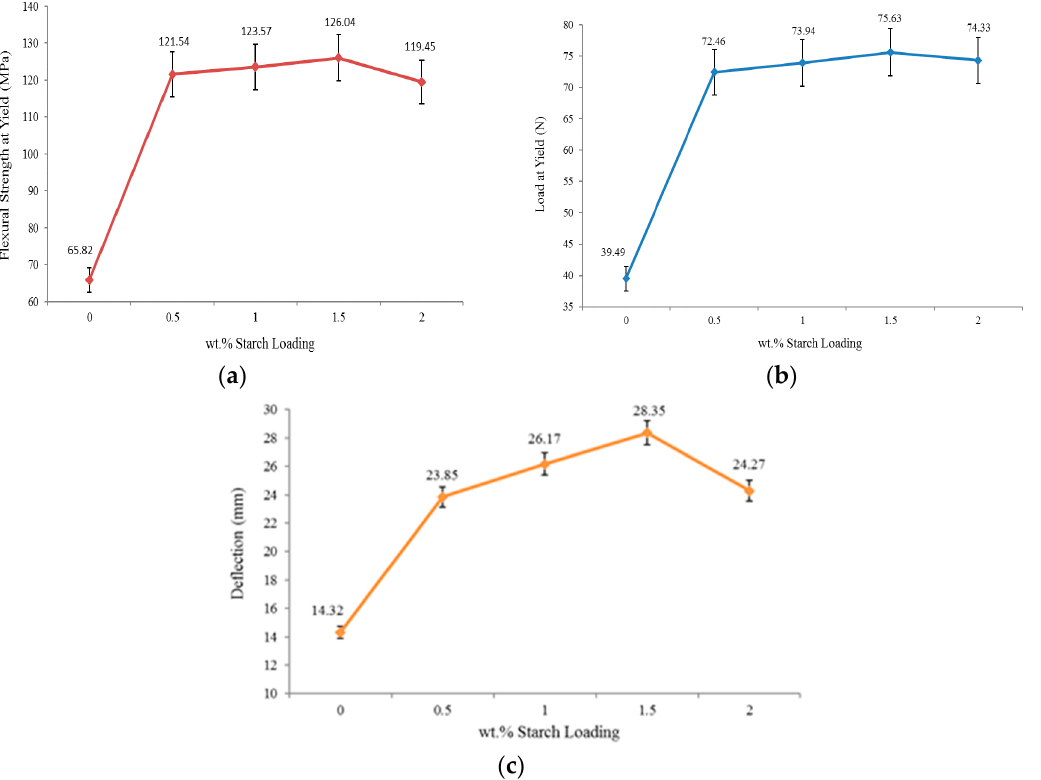
Figure 5. ( a ) Flexural strength at yield; ( b ) load at yield; and ( c ) deflection.